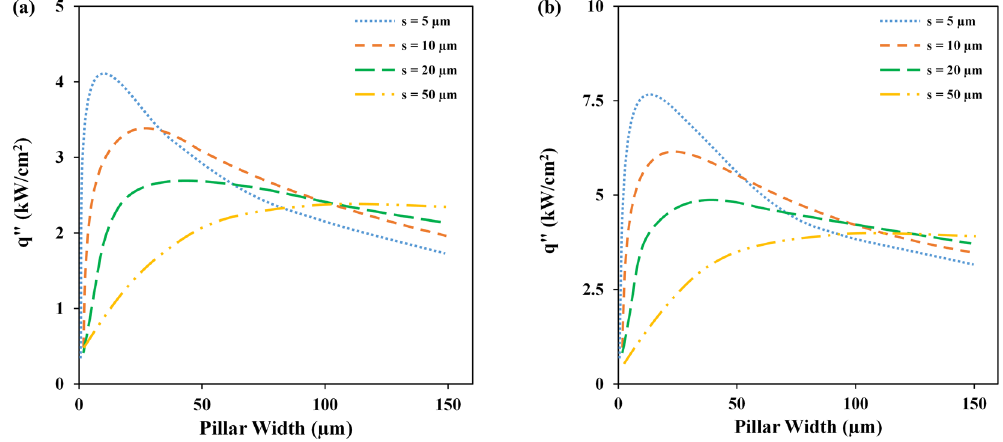
Figure 10. CHF values estimated from the model for a surface with ( a ) copper and ( b ) diamond